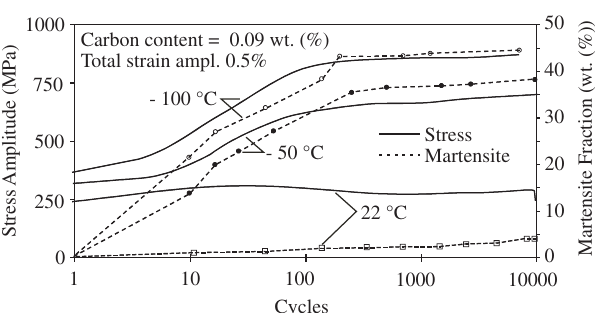
Figure 9. Influence of temperature on test specimens of relatively high carbon content at a constant strain amplitude.